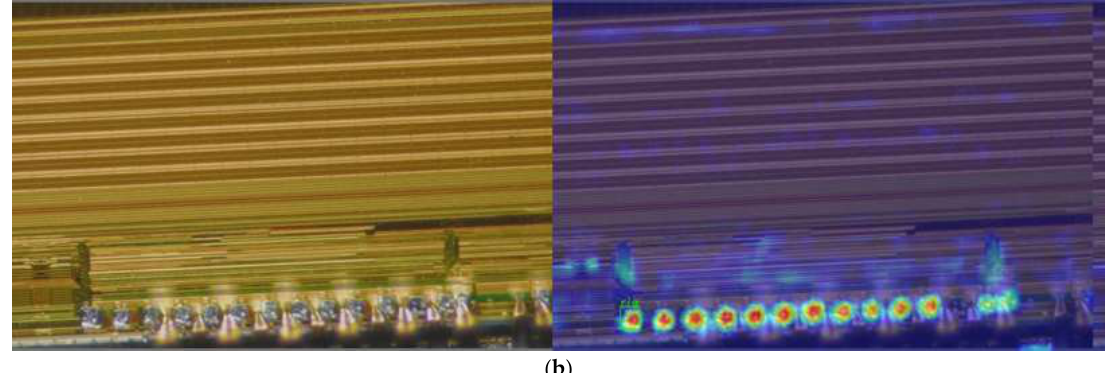
Figure 11. Grad-CAM visualization results. ( a ) YOLOv5s. ( b ) Our method.